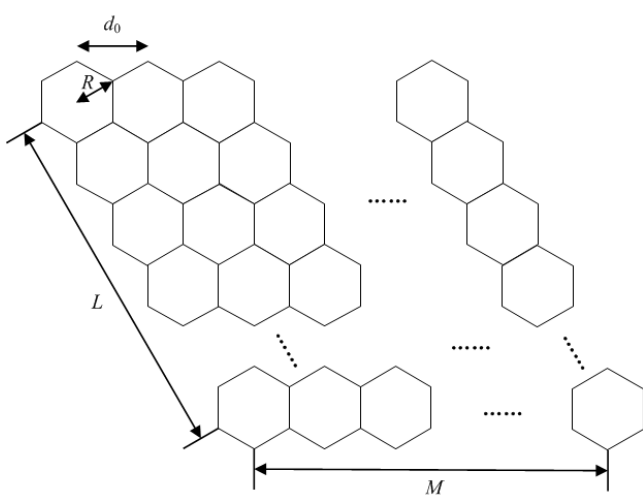
Figure 2. The hybrid 2D beam